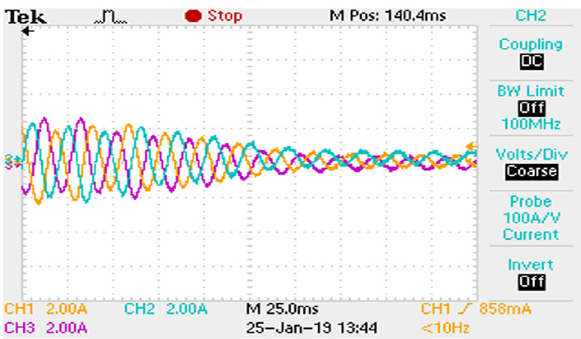
Figure 5: Current waveform captured through DSO.